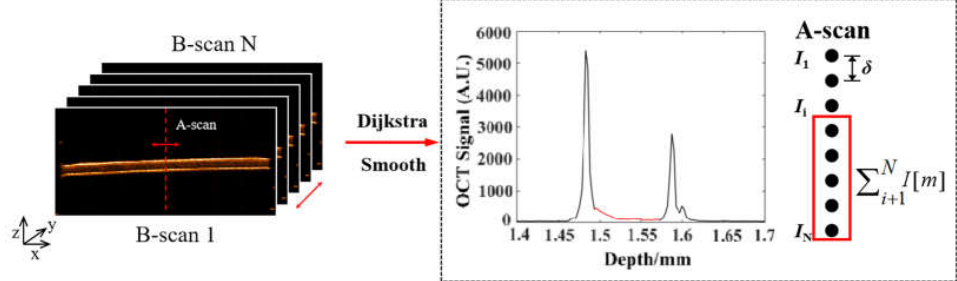
Figure 4. Modified depth-resolved attenuation coefficient quantification algorithm based on a single-scattering model. The red solid line indicates the area of intensity signal within the skin excluding the cuticle.